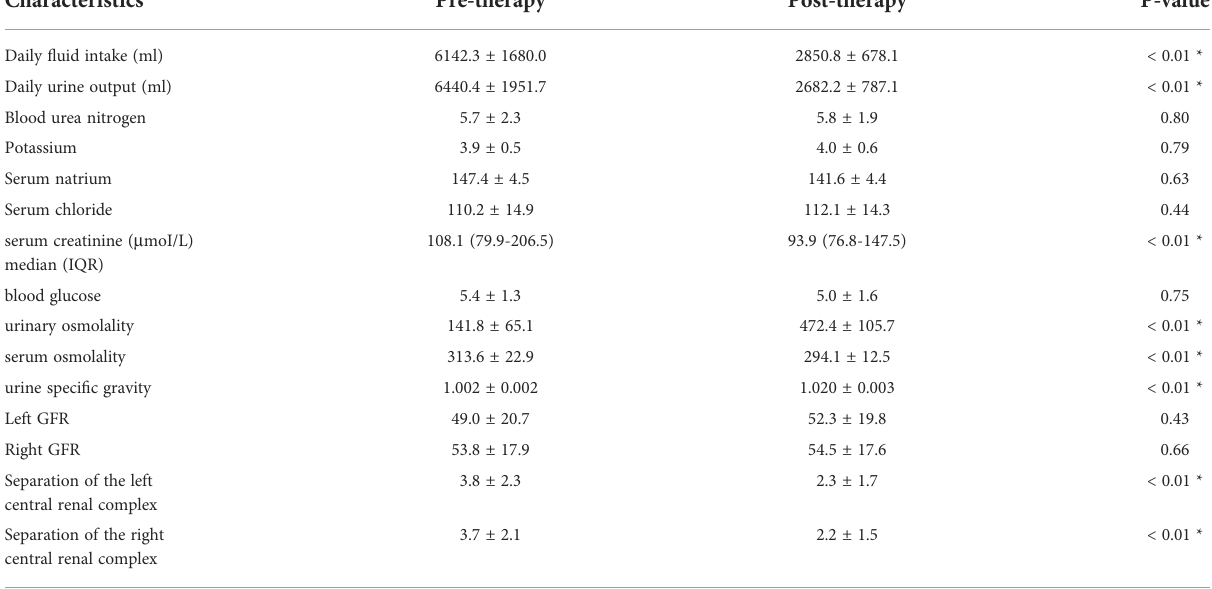
TABLE 3 Differences in pre- and post-therapeutic parameters for DI